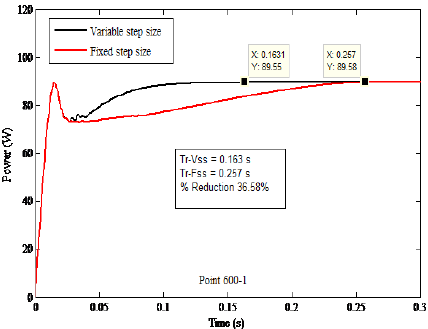
Fig. 8: Output power: Zoom in Point